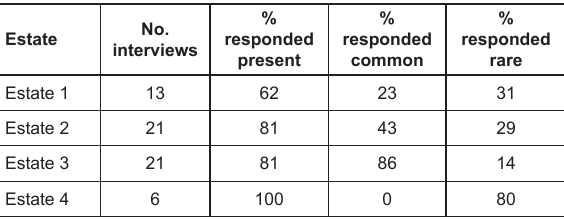
Table 1. Community interview results regarding presence of Lanthanotus